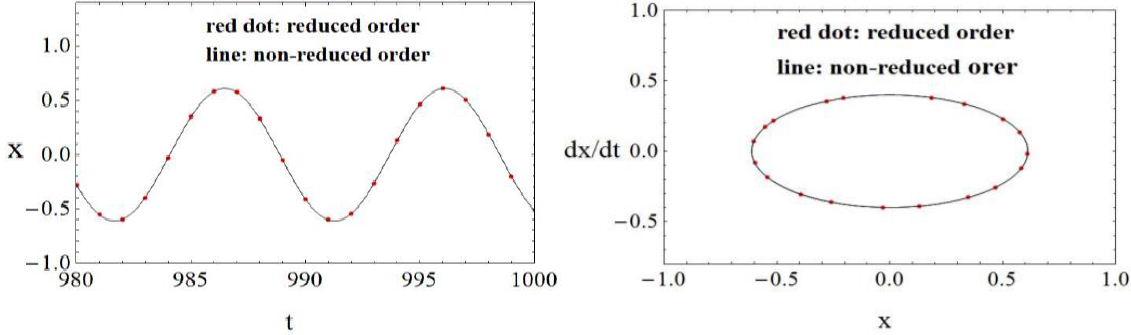
Figure 3. Comparison of the analytical periodic solutions derived from non-reduced order via reduced order technique.